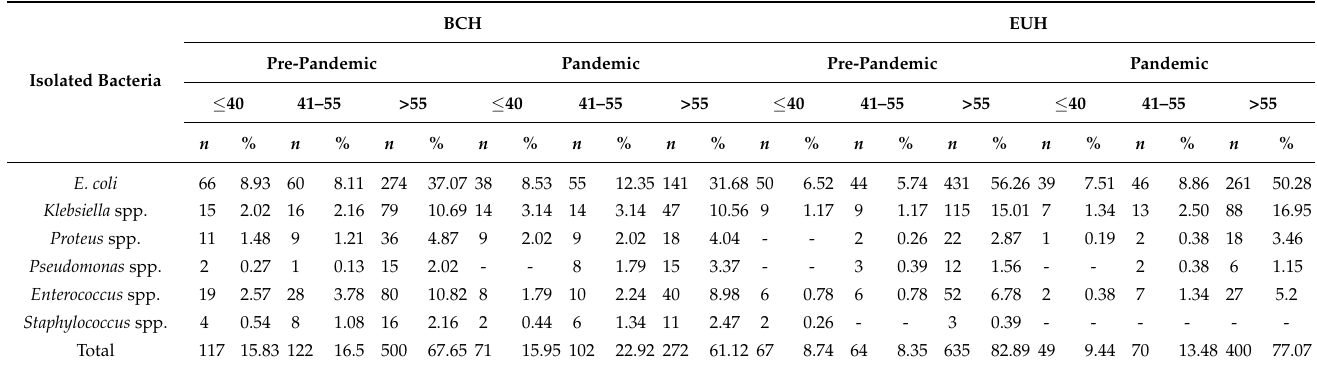
Table 2. Uropathogens in female patients of various age groups in BCH and